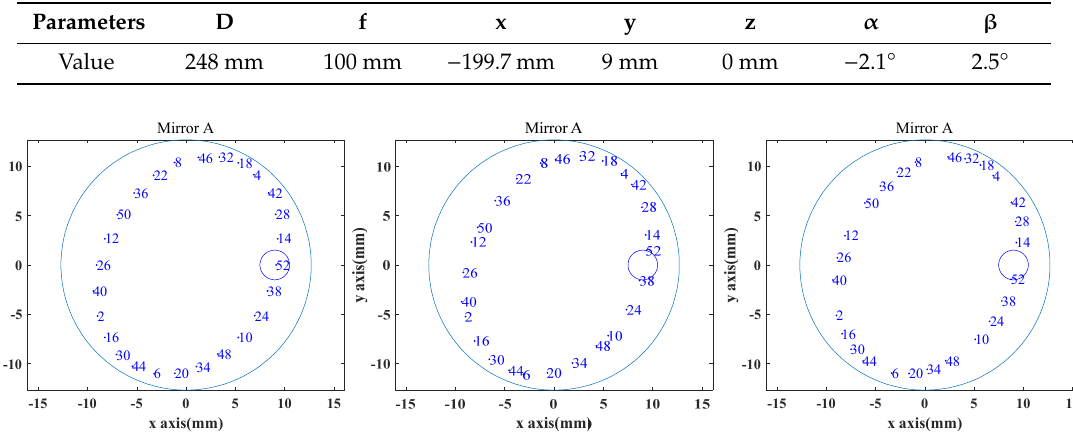
Figure 4. The spot distribution of a two mirror-based Herriott cell on Mirror A with ( a ) D , ( b ) D + 0.5 mm and ( c ) D – 0.5 mm.